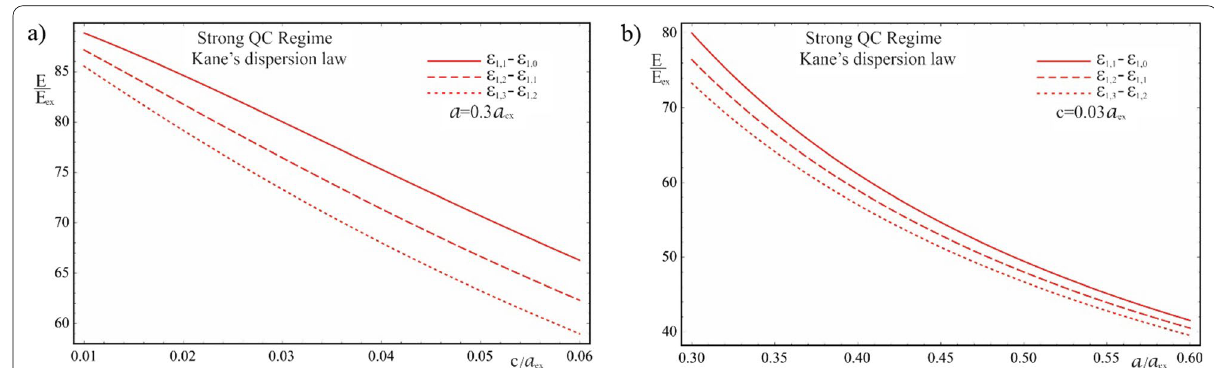
Fig. 7 The dependence of the interlevel distances of the first family of electron energy levels on the semiaxes of the ellipsoidal QD in the case of a complicated (Kane’s) dispersion law: ( a ) on the minor semiaxis c at the fixed value of the major semiaxis a , ( b ) on the major semiaxis a at the fixed value of the minor semiaxis